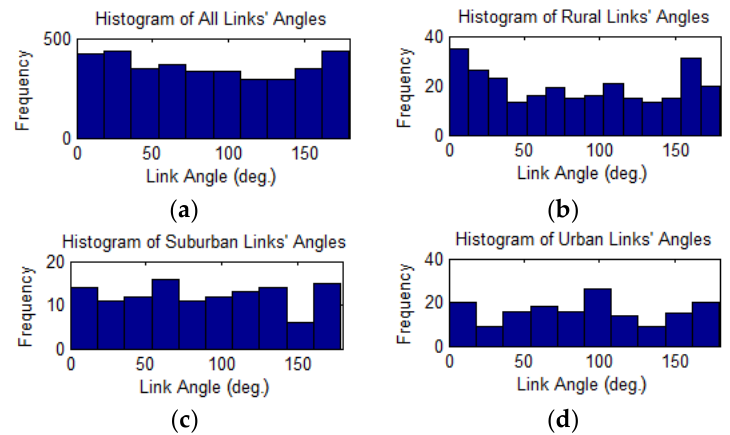
Figure 3. The distribution of CML angles. ( a ) all Israel, ( b ) top of northern Israel as rural, ( c ) Hasharon as suburban, ( d ) Tel Aviv as urban [6].